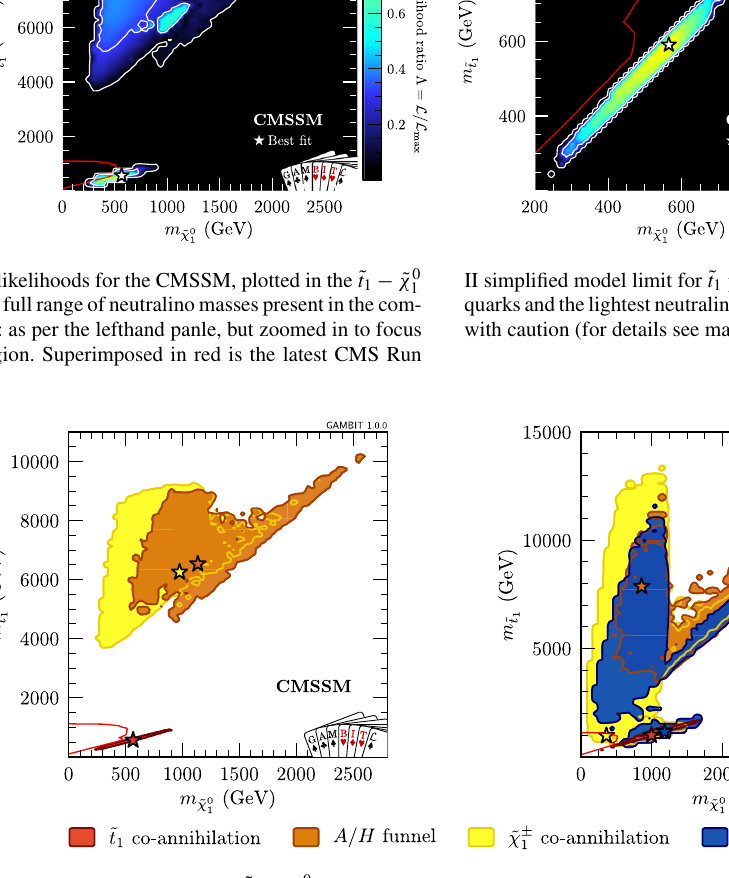
is the latest CMS Run II simplified model limit for ˜ t 1 pair production mass plane, 1 and subsequent decay to t quarks and the lightest neutralino [319]. This limit should be interpreted with caution (for details see main